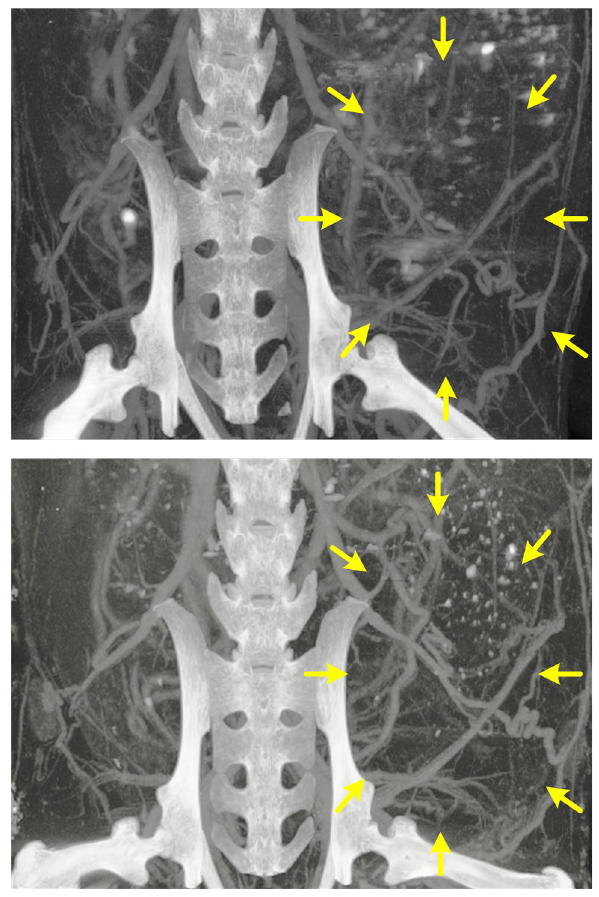
Figure 5. Series of preclinical in vivo contrast-enhanced microscale computed tomography (microCT) images of an aggressive breast cancer (yellow arrows) acquired in the same animal at reference baseline (top) and 2 wks